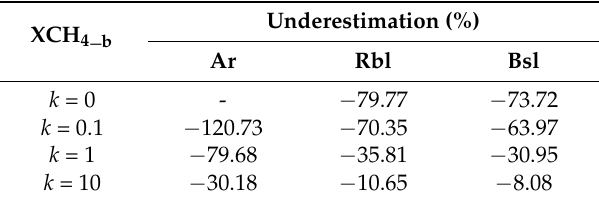
Table 2. S (XCH 4_b , α = 0) resulting from constant ρ s assumption for wavelengths 2239 to 2299 nm.